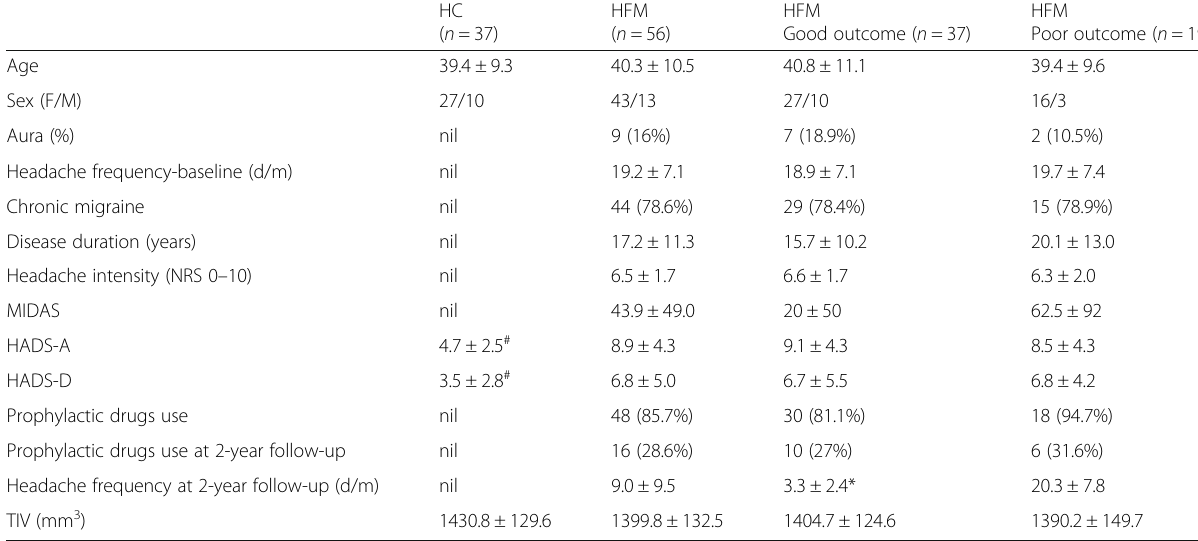
Table 1 Demographics, clinical profiles, and neuroimaging data of patients with HFM and HC